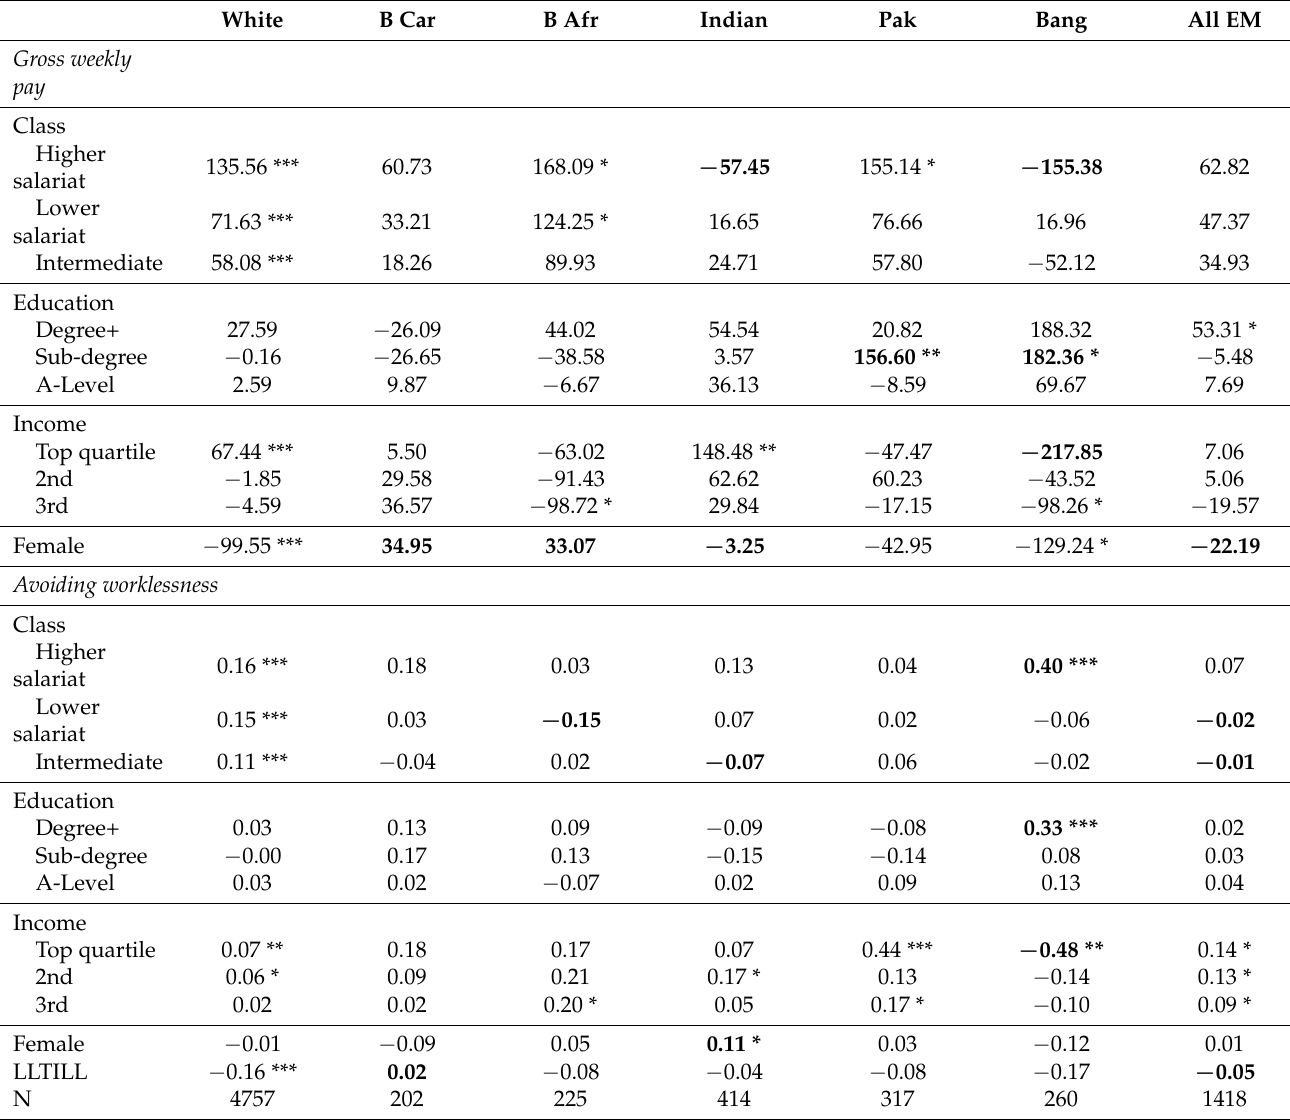
Table 8. Average marginal effects (AME) on avoidance of worklessness (%) and gross weekly pay (GBP) conditional on employment by family situation and